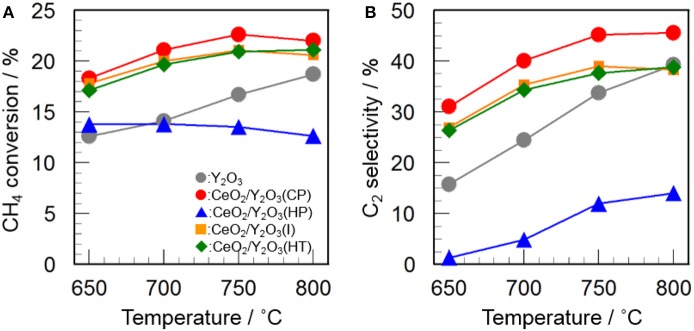
Catalytic activity of 3 mol% CeO2/Y2O3 for the OCM reaction. (A) CH4 conversion and (B) C2 selectivity.